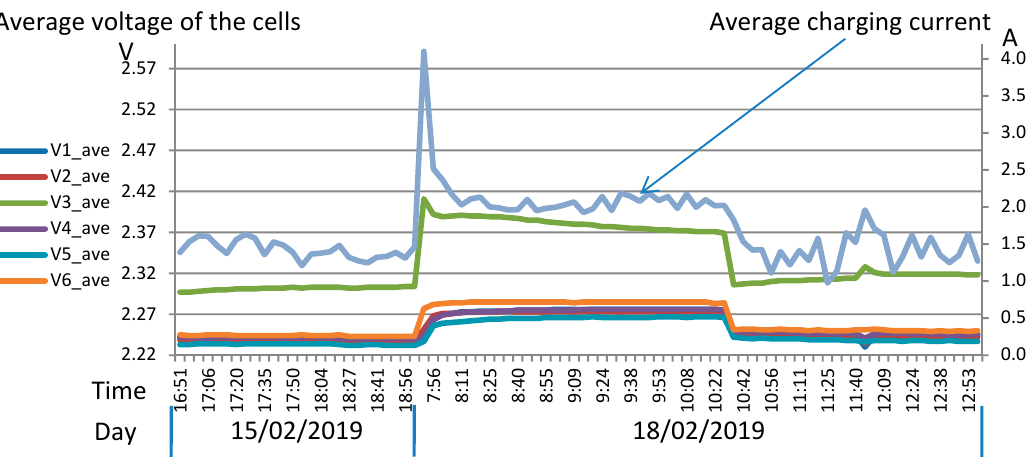
Figure 7. Results of measurements in the laboratory: resistance of 6 cells vs. temperature.